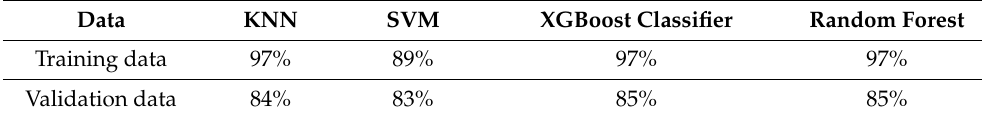
Table 4. Comparison of ML methods’ performance.